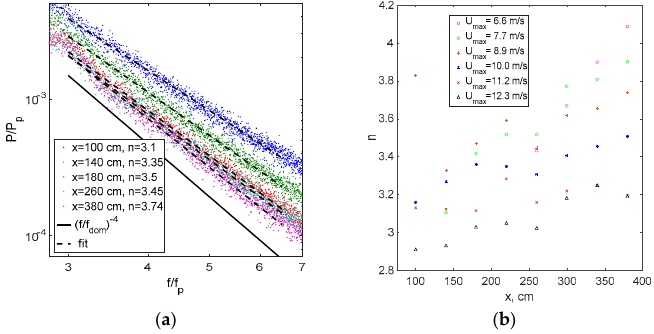
Figure 7. ( a ) High-frequency part of the surface elevation power spectrum for U max = 8.9 m/s and various fetches; ( b ) the value of n in the power law in Equation (6) for the spectral tails.